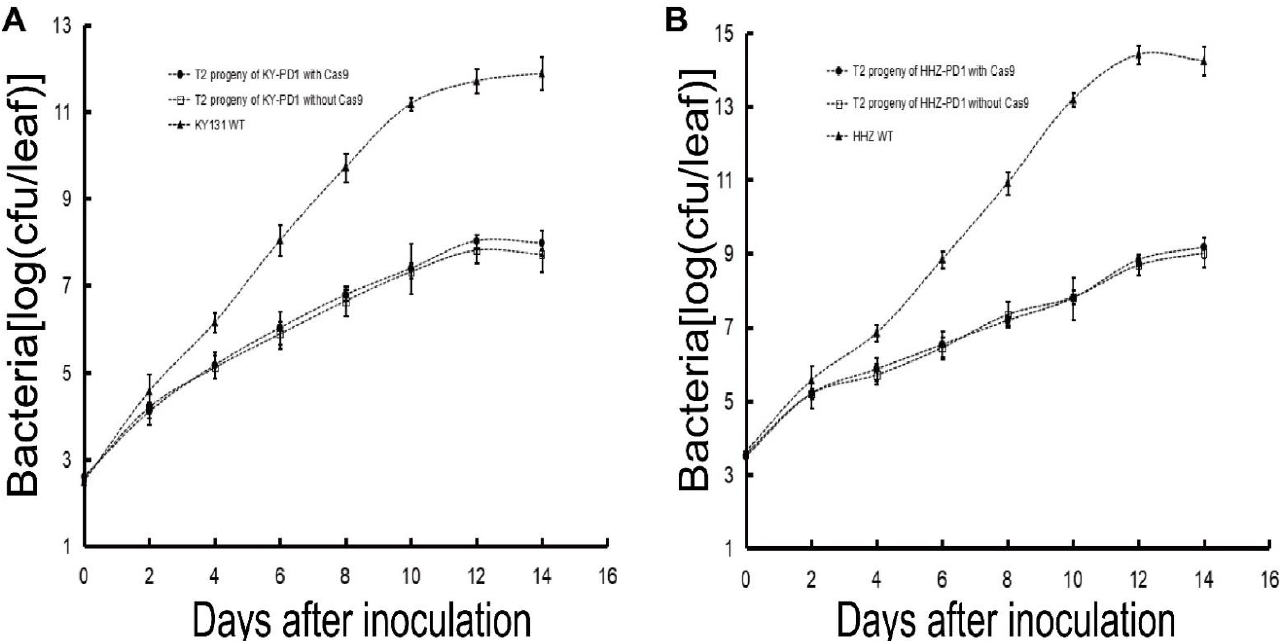
Figure 5. Bacterial growth analysis of Xoo strain PXO99 in leaves of wild-type and transgenic rice with/without Cas9 in T 2 progeny. ( A ) Bacterial growth analysis of Xoo strain PXO99 in the leaves of wild-type KY131, T 2 transgenic line KY-PD1 with Cas9, and T 2 transgenic line KY-PD1 without Cas9. The results revealed that both PXO99-inoculated KY-PD1 with/without exogenous DNA showed lower growth rates and total bacterial counts than the wild-type KY131. ( B ) Bacterial growth analysis of Xoo strain PXO99 in the leaves of wild-type HHZ, T 2 transgenic line HHZ-PD1 with Cas9, and T 2 transgenic line HHZ-PD1 without Cas9. The results revealed that both PXO99-inoculated HHZ-PD1 with/without exogenous DNA showed lower growth rates and total bacterial counts than the wild-type HHZ.